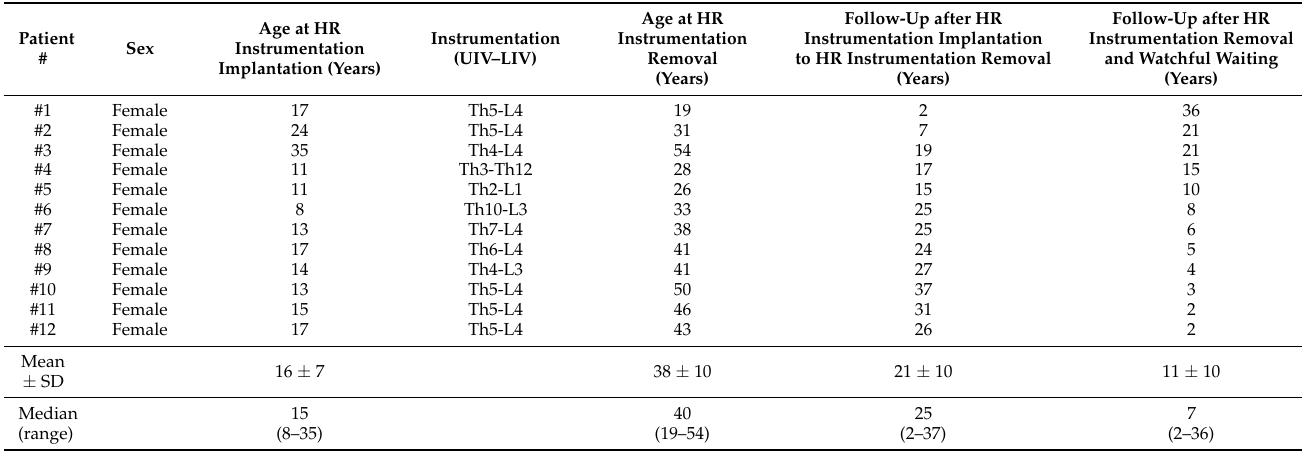
Table 1. Baseline